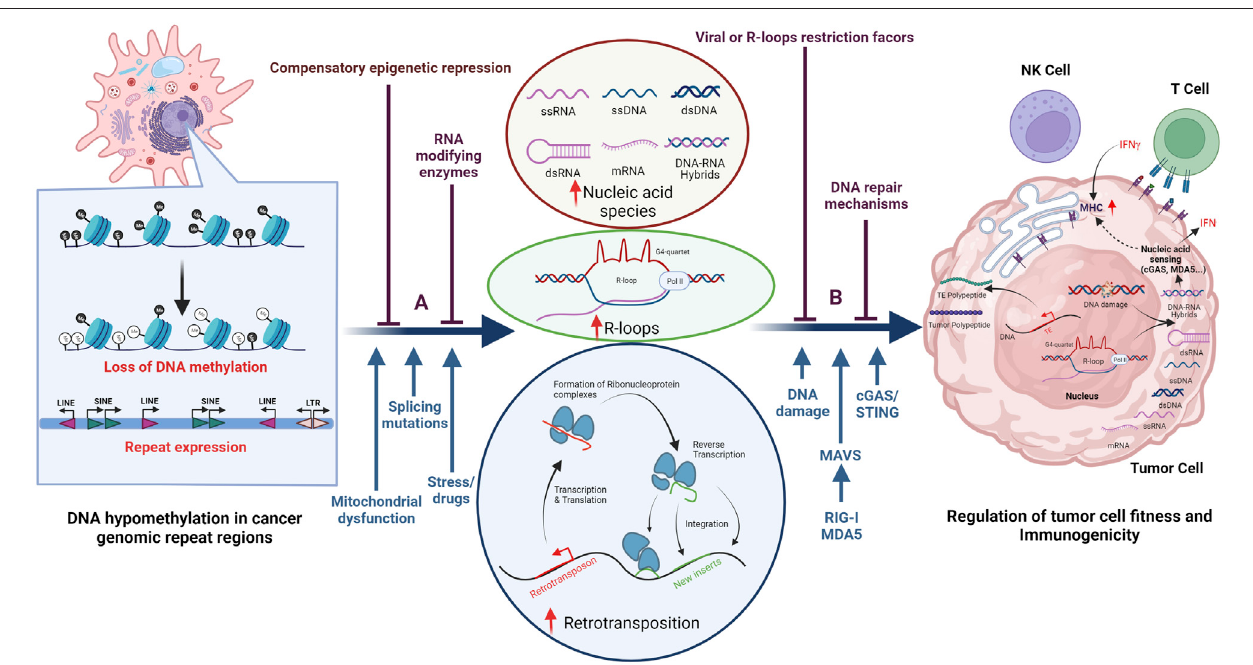
FIGURE 3 | Establishment of an evolutionarily conserved truce contributes to cancer cell survival. Cancer cells often display DNA hypomethylation (open black circles) in the repetitive parts of the human genome, as displayed in the left part of the fi gure. De-repression of these regions can result in the accumulation of various nucleicacidspecies(NAS),R-loopformation,aswellaschangesingeneexpressionand/orDNAdamageasillustratedinthemiddlepartofthe fi gure.Theconsequences forthetumor cellareillustrated intherightpartofthe fi gure andinclude induction ofDDR aswellasactivationoftheinnateandadaptive immune system.Illustrated abovethehorizontalbluearrowsareepi-transcriptomic (A) andpost-transcriptional (B) mechanismsthathavebeenproposedtocounteractthenegativeeffectsthatde- regulation of repeat regions has on cancer cell survival. Notably, some of these factors belong to both epi-transcriptomic and post-transcriptional categories. Indicated belowthehorizontalbluearrowsarefactors thatcontributetodecreasedcell fi tnessaswellasviralsensingmechanisms.Besidesde-regulatedrepeatexpression,other factors such as endogenous replication stress, DNA damage, splicing mutations, and some mitochondrial dysfunctions can all lead to increased NAS in the